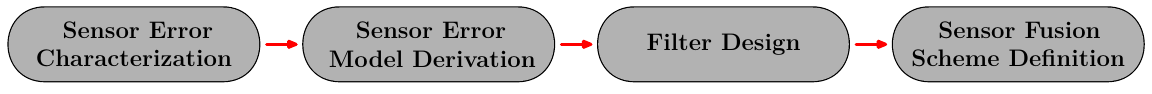
Figure 1. Schematic representation of the End-to-End